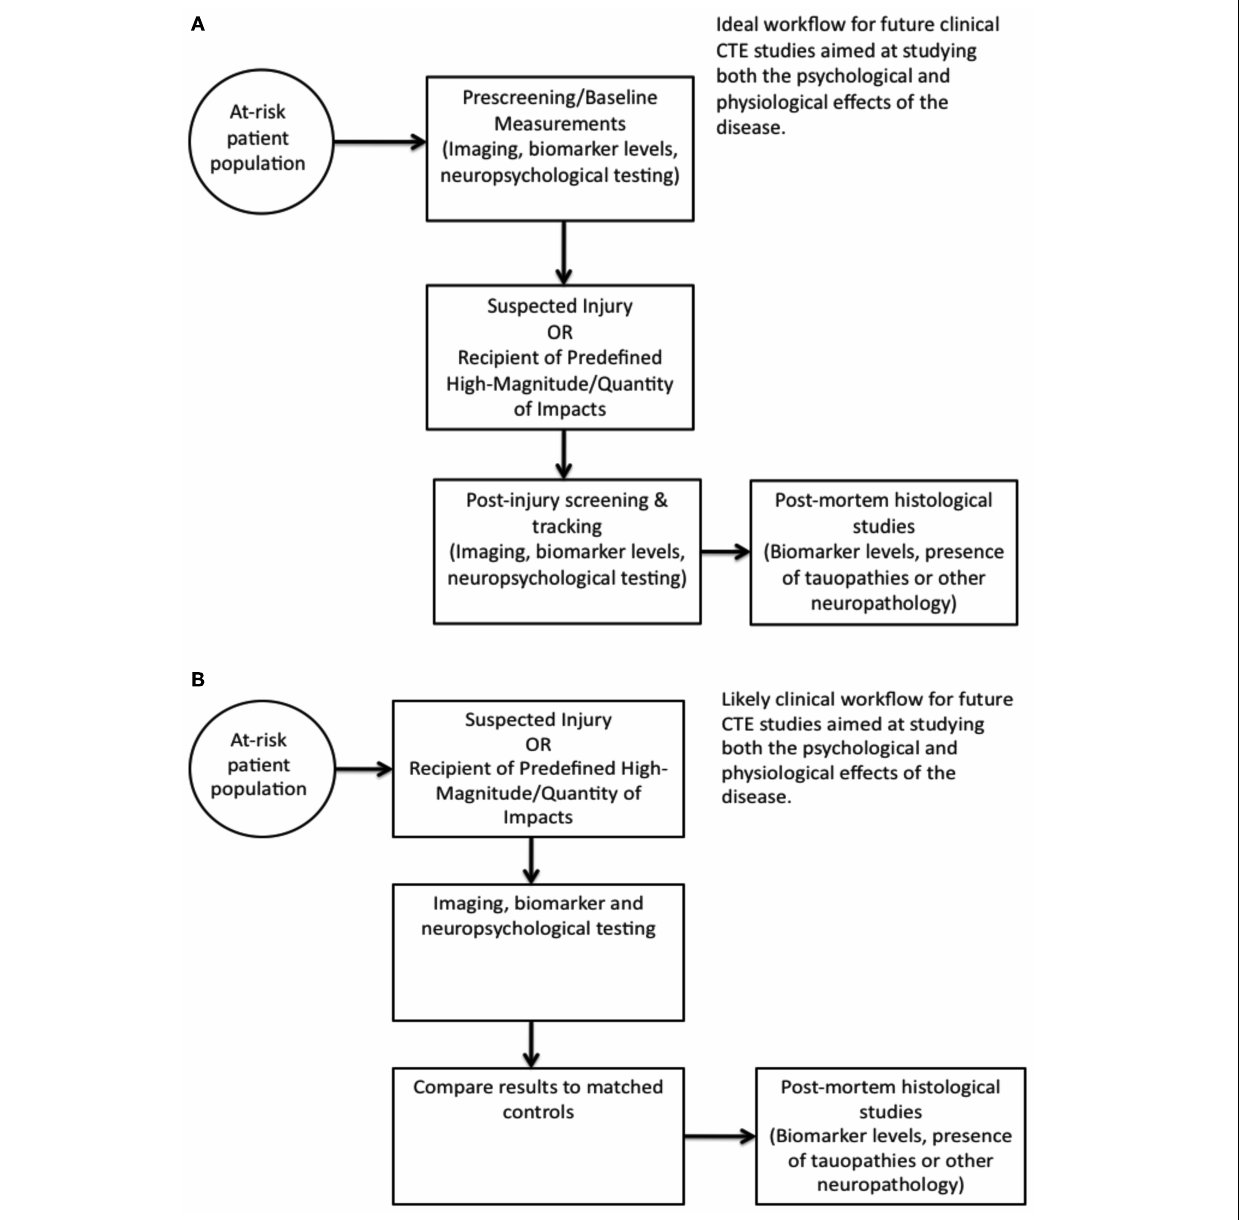
FIGURE 1 | Imaging and biomarker studies may be useful in improving understanding of the role of repetitive concussive and subconcussive injury in disease development. Two experimental paradigms are presented representing a potentially more ideal, but costly, scenario (A) and the more cost-conscious approach (B)